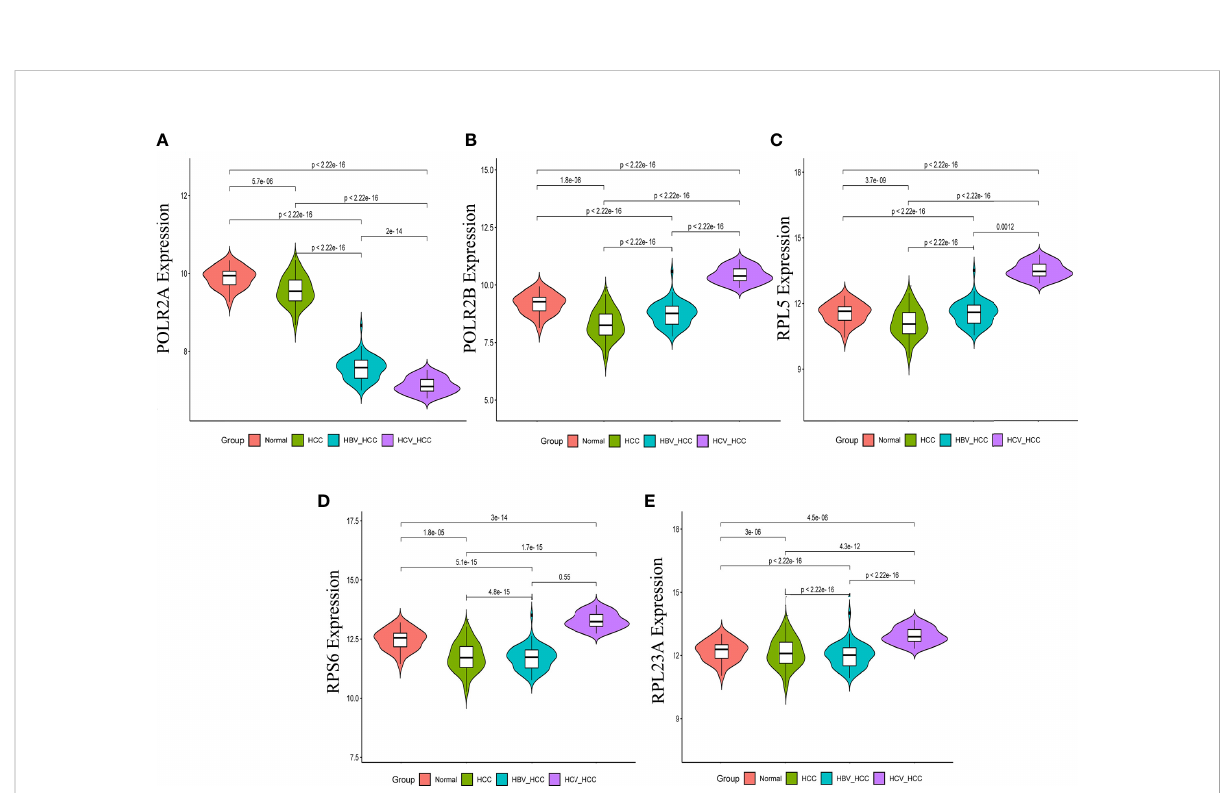
FIGURE 7 Expression of hub genes in HCC, HBV-HCC and HCV-HCC liver tissues. The expression data of POLR2A (A) , POLR2 (B) , RPL5 (C) , RPS6 (D) and RPL23A (E) in different groups were analyzed by